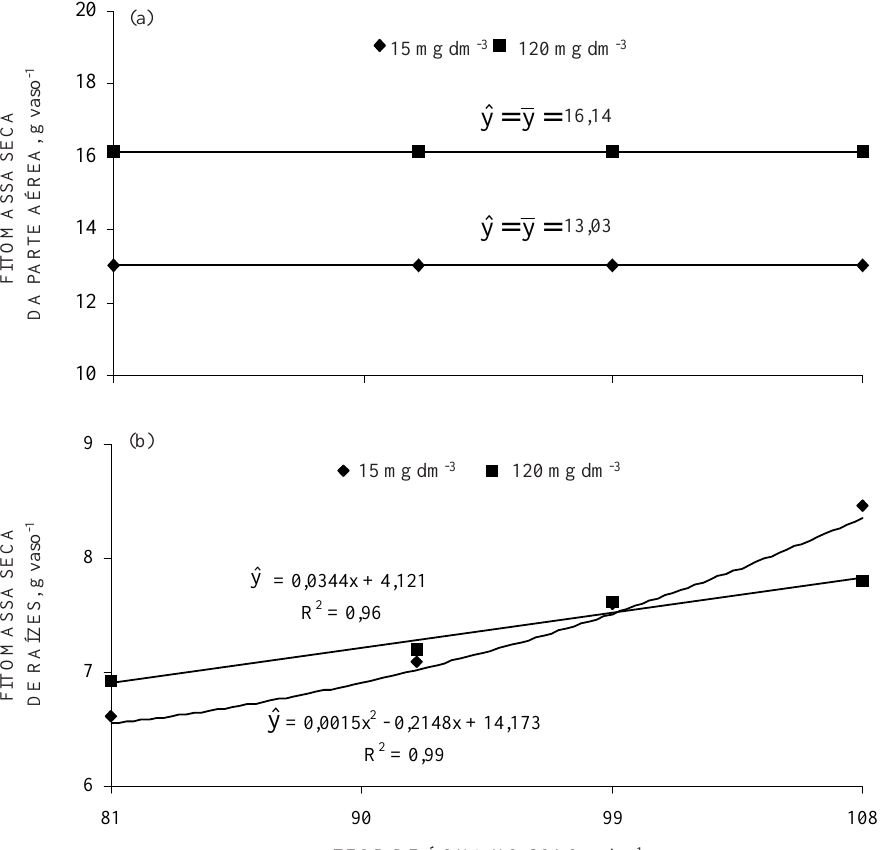
Figura 5. Acúmulo de fitomassa (a) na parte aérea e (b) nas raízes do milheto (28 DAE), considerando os teores de água no solo, correspondentes aos potenciais testados, e as doses de potássio. Símbolos = valores observados; linha = valores